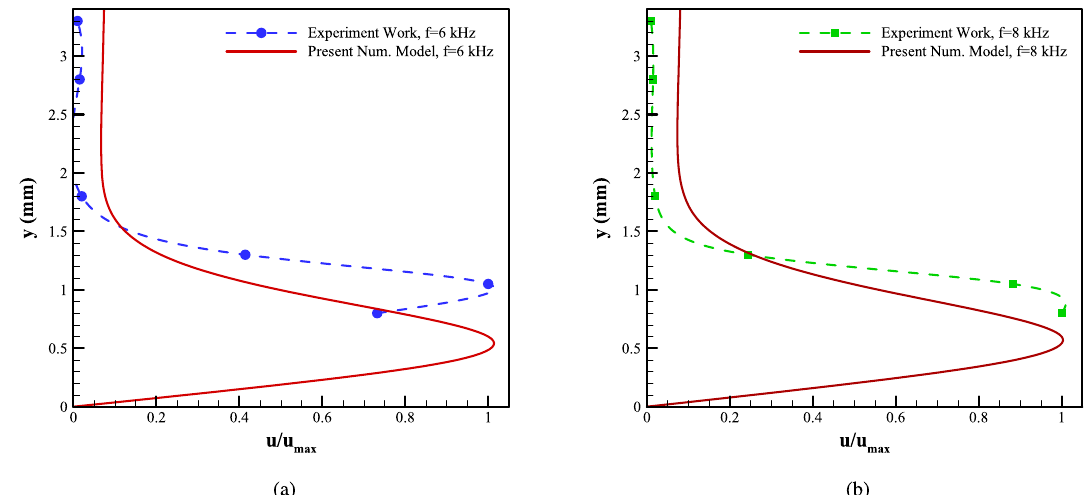
Figure 6. Comparison of velocity profiles from the experiments and the presented numerical scheme for a V = 6 kVpp, f = 6 kHz, and b V = 6 kVpp, f = 8 kHz, at 5 mm downstream of the exposed electrode’s leading